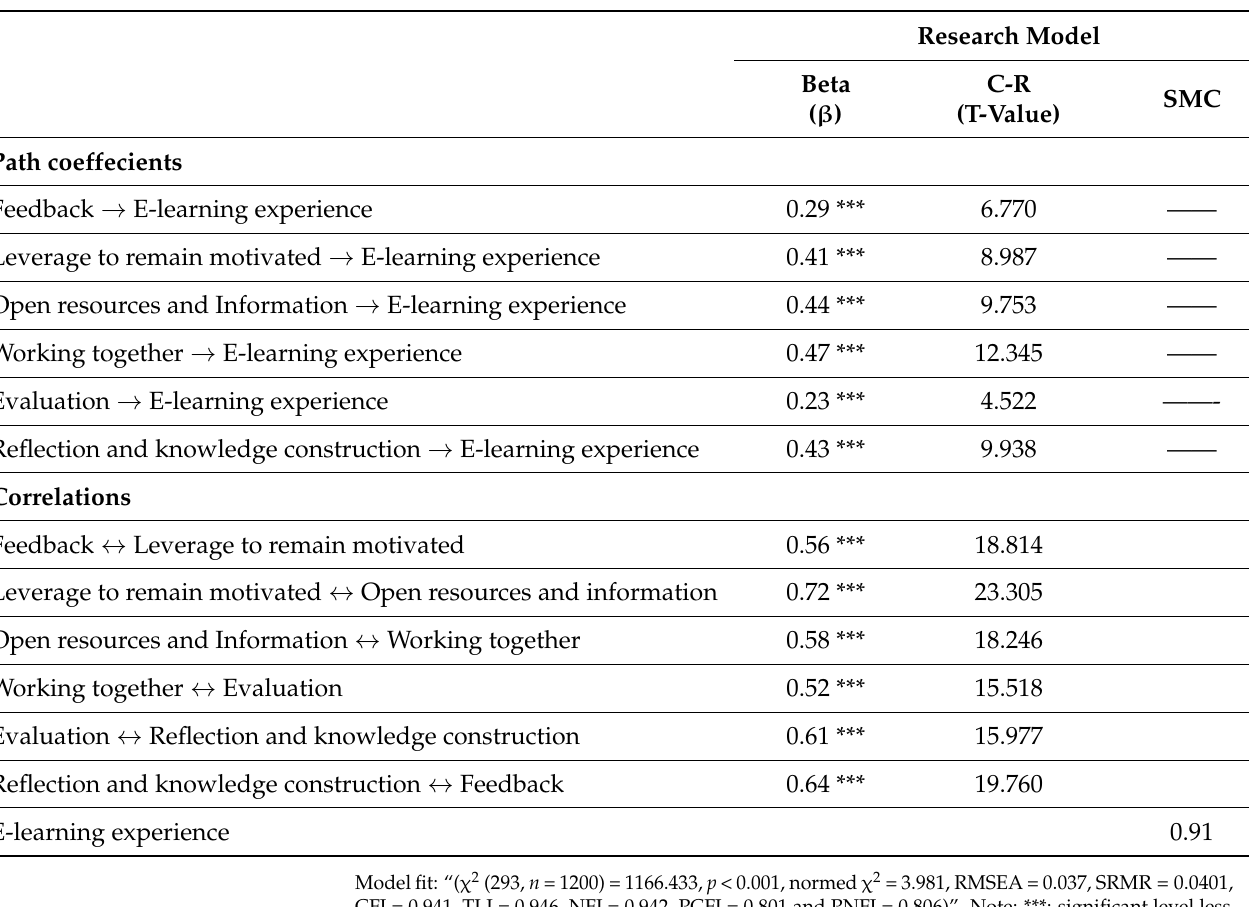
Table 3. Results of the hypothesized